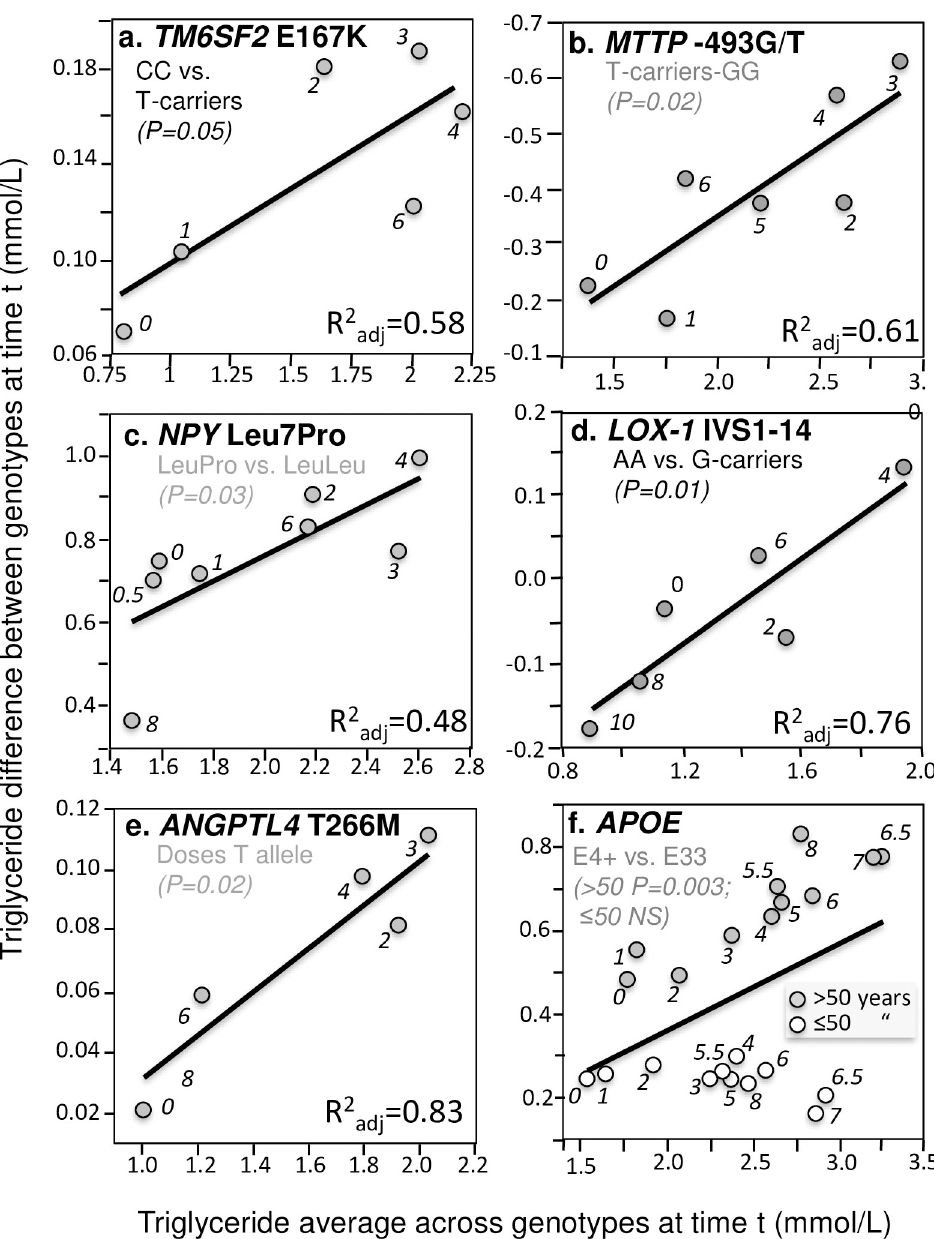
Fig 7. Quantile-dependent expressivity plots for postprandial triglycerides by ANGPTL4 , APOE , LOX-1 , MTTP , NPY , and TM6SF2 polymorphisms. Derived from the postprandial response figures published by: (a) O’Hare et al. for 853 CC homozygotes vs.130 T-carriers for the TM6SF2 loss-of-function variant (rs58542926) [87]; (b) Lundahl et al. for 24 GG homozygote vs. 36 carriers of the T-allele of the -493G/T polymorphism of the microsomal triglyceride transfer protein ( MTTP , rs1800591) (P = 0.02) [69]; (c) Schwab et al. for 7 LeuPro heterozygotes vs. 7 LeuLeu homozygotes for the Leu7Pro polymorphism of the neuropeptide Y ( NPY , rs16139) gene [109]; (d) Musso et al. for 26 AA homozygotes vs. 54 G-carriers of the lectin-like oxidized LDL receptor-1 ( LOX-1 ) IVS4-14 A/G polymorphism in the pooled sample of NASH and healthy control patients [82]; (e) Talmud et al. for 1355 TT, 1108 TM, and 262 MM genotypes of ANGPTL4 T266M (rs1044250) [118]; (f) Carvalho-Wells et al. for 143 E33 and 64 E4 carriers verifying their different postprandial response by age when matched for average triglyceride concentrations